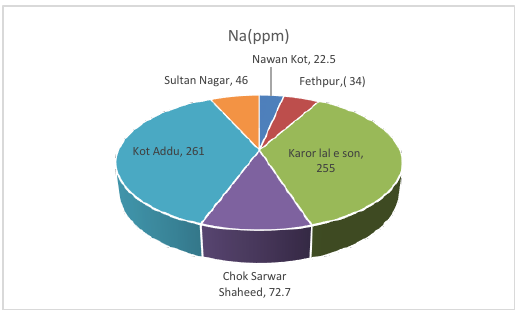
Table 14: Family wise distribution of weed species infesting